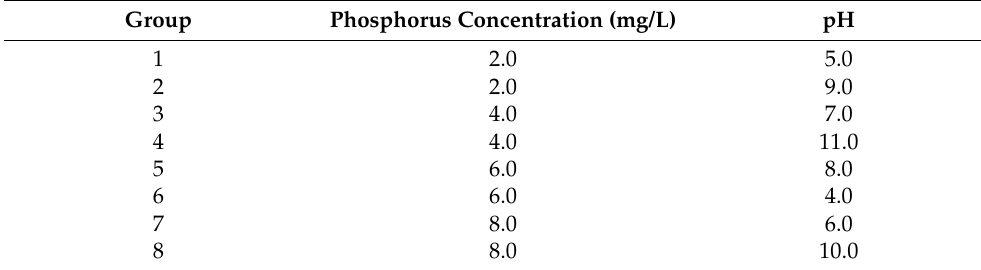
Table 4. The uniform design of the effects of phosphorus concentration and pH on Scenedesmus dimorphus